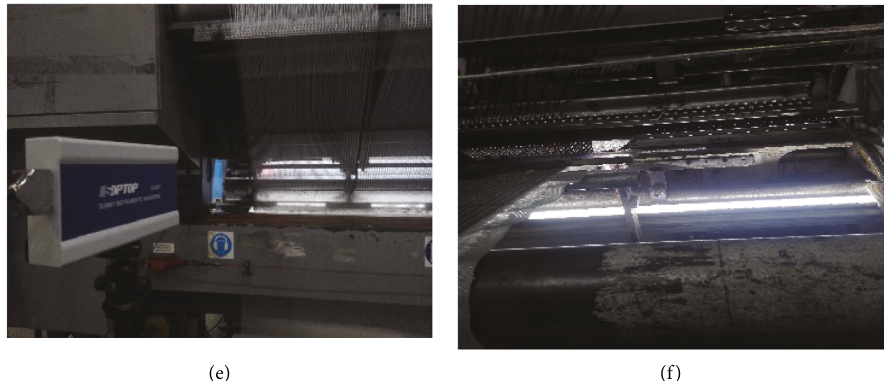
Figure 6: Vibration test positions. (a) Motor spindle. (b) Needles. (c) Hook bed. (d) Linkage. (e) Hook driven shaft. (f) Bottom pressing plate.